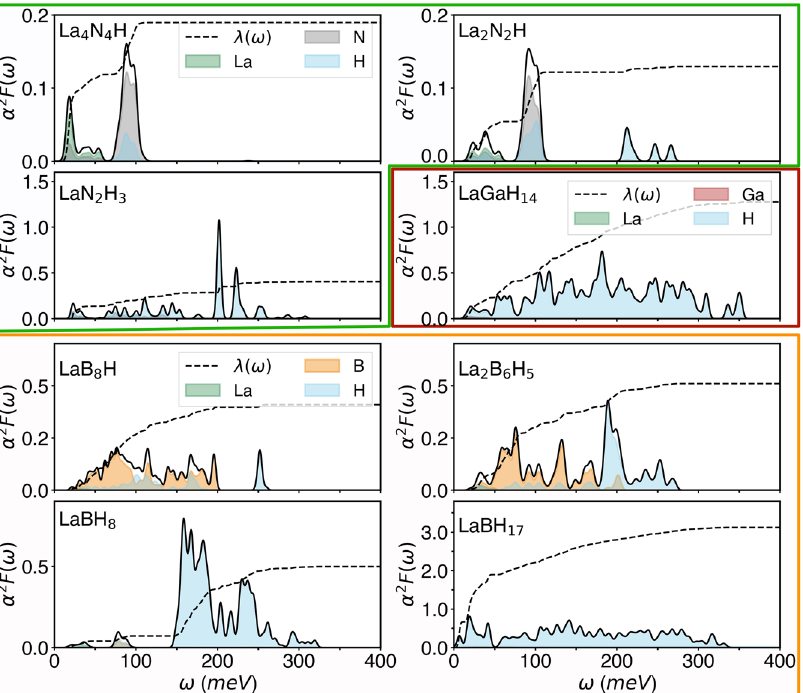
Fig. 4 Total and atom-projected Eliashberg function [ α 2 F ( ω ), solid lines], and ω -dependent e-ph coupling [ λ ( ω ), dashed lines] for stable La – B – H and La – N – H hydrides, and metastable LaGaH 14 and LaBH 17 . The atom projections on La, B, N, Ga, and H are shown in green, gray, orange, red, and blue, respectively. The Eliashberg function and ω -dependent e-ph coupling λ ( ω ) are de fi ned in Supplemental Material. Note: due to the large differences in values, the y -axis scale is different for each sub fi